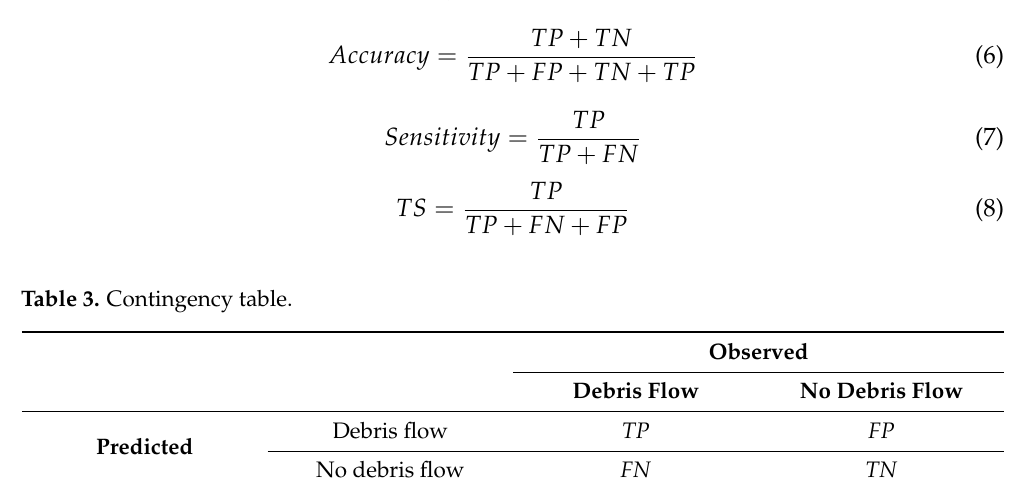
Table 3. Contingency table. Predicted